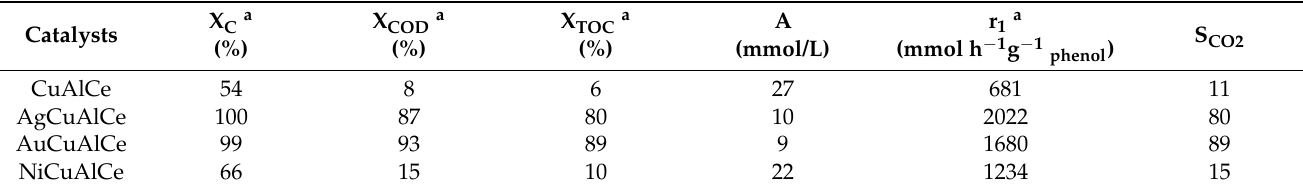
Table 3. Activity for the catalytic wet air oxidation of phenol after 180 min of reaction. Phenol conversion (X C ), COD removal (X COD ), TOC removal (X TOC ), initial rate (r i ), intermediate concentration of catechol (A) and CO 2 Selectivity (S CO2 ) as a function of time for bimetallic copper-based and monometallic copper catalysts. X C a Catalysts (%) Catalysts AgCuAlCe 100 AuCuAlCe a Obtained after 180 min of